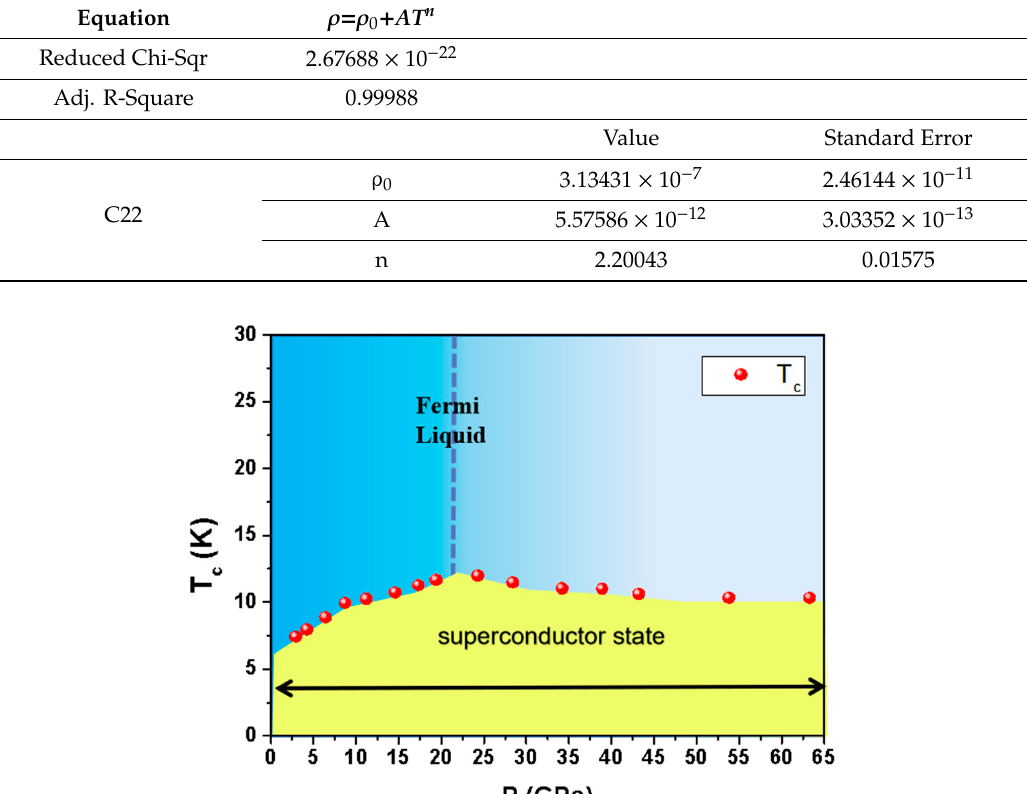
Table 1. To analyze the normal state behavior under pressure, we have applied the power-law formula ρ ( T ) = ρ + AT n to the resistivity of La, where ρ 0 0 and A are the residual resistivity and the temperature coe ffi cient, respectively. The international system of units is used in the data fitting. The units of ρ , A and T are Ω · m, Ω · m · K − n and K, respectively. The fitting parameters of the normal state conductivity in terms of the power law format are ρ ( T ) = ρ 0 + AT n at 38.9 GPa. Equation ρ = ρ 0 + AT n Reduced Chi-Sqr